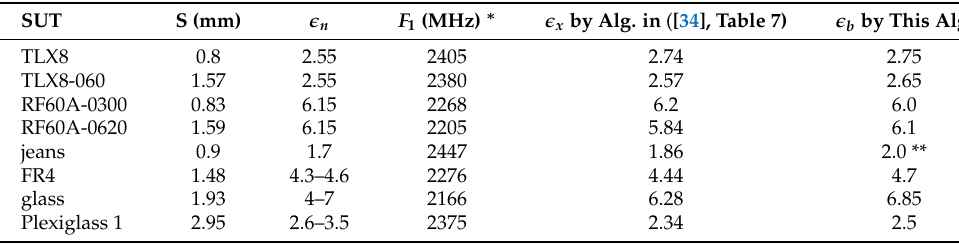
Table 2. Testing this reference data set-based algorithm (RDSA) against known permittivities and the variational method-based algorithm (VMA) from [34].